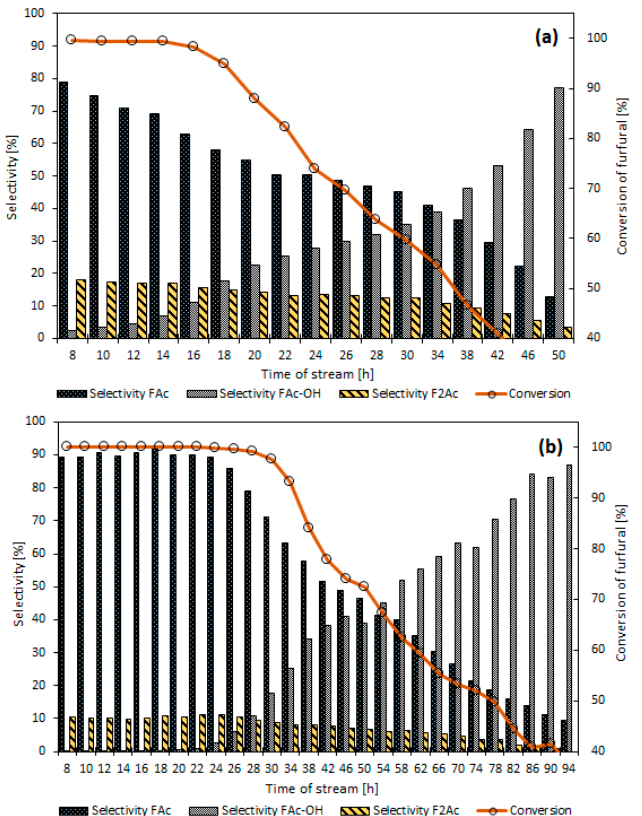
Figure 4. ( a ) Aldol condensation of furfural with acetone in molar ratio of 1:2.5 with 5 wt.% water over regenerated MgAl catalyst, ( b ) furfural with acetone in molar ratio 1:5 with 5 wt.% water addition. Tests were performed in a continuous-flow reactor at constant temperature 40 °C and pressure 1 MPa, flow of feedstock 10 g/h.